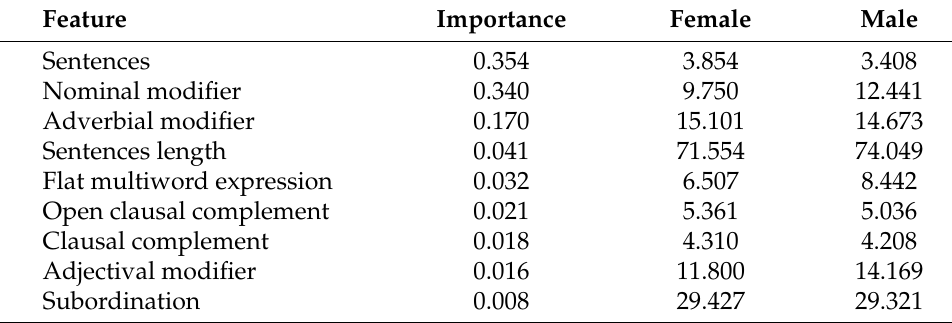
Table 7. Syntactic feature importance and mean